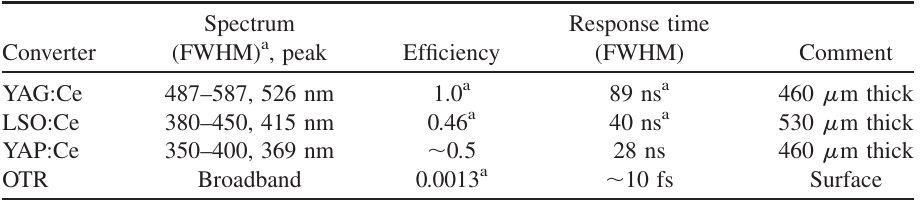
13. (Color) Comparison of beam images at 325 MeV at APS from (a) COTR and (b) with mitigation of COTR using the 400 nm (cid:2) 40 nm bandpass filter (BPF) and LSO:Ce TABLE II. Summary of some radiation converter screen properties for Ce-doped scintillators and an Al OTR screen.